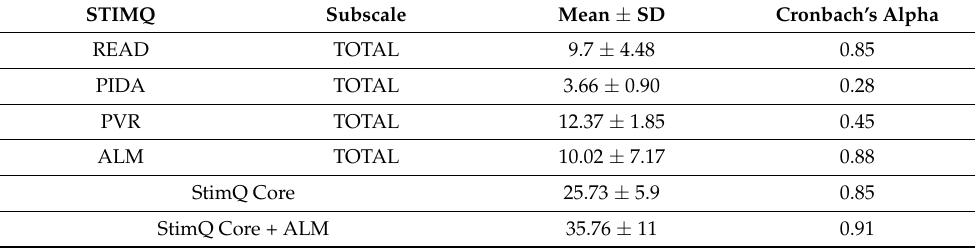
Table 3. Cronbach’s alpha of subscale and total scores for toddlers.